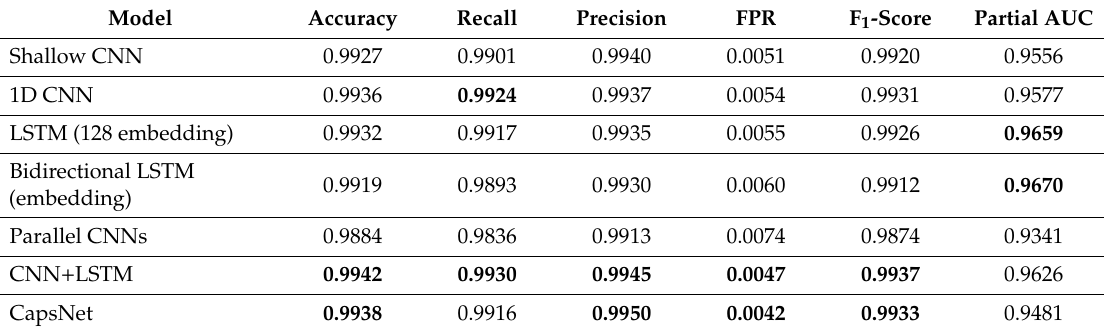
Table 3. Results of random assignment experiment with the test dataset.